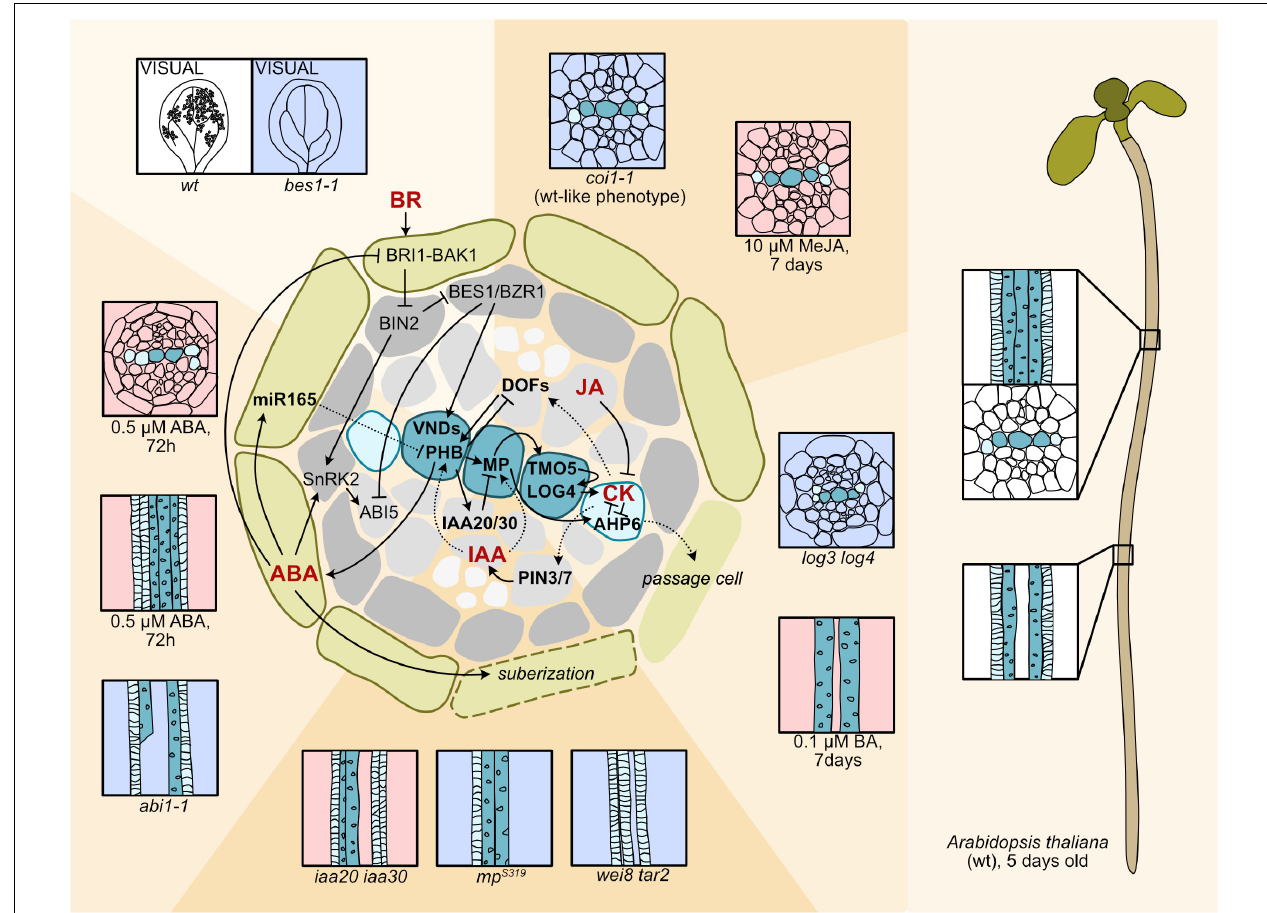
FIGURE 1 | Hormone circuits controlling root xylem development. In the Arabidopsis seedling root, to the right, spiral-walled protoxylem vessels (light blue-green) differentiate first followed by the pitted metaxylem vessels (dark blue-green). To the left a cartoon depicting a cross section focusing on the stele surrounded by the endodermis. Cell types are as indicated: endodermis (green), pericycle (dark gray), procambium (light gray), protoxylem (light blue-green), metaxylem (dark blue-green). Signaling pathways affecting xylem patterning and differentiation are shown on top of the cross section. Hormones are in bold red letters. Arrows indicate activation, bars inhibition. Dashed arrows indicate movement. Phenotypic consequences of hormone treatments or biosynthesis/signaling perturbations for selected experiments are displayed around the cross section. Decreased hormone levels/signaling (light blue background), enhanced levels/signaling (light red background). A PIN3/7 mediated lateral transport focuses auxin (IAA) to a central axis within the stele (Bishopp et al., 2011). Here, auxin-activated MP induces TMO5 that activates LOG3 and LOG4 resulting in CK biosynthesis (De Rybel et al., 2014; Ohashi-Ito et al., 2014). MP also activates AHP6 which inhibits